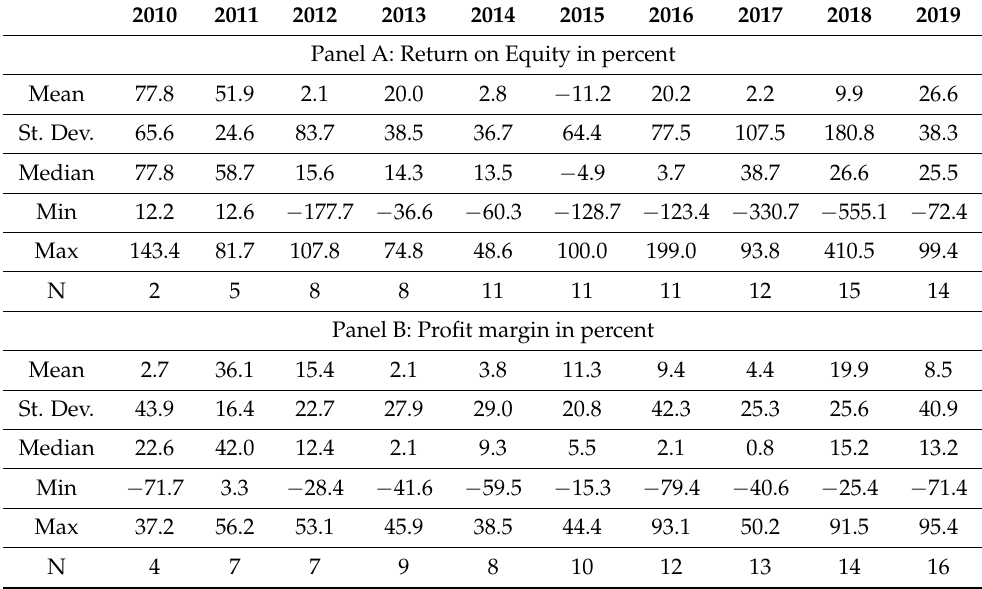
Table 6. Financial performance of FinTech